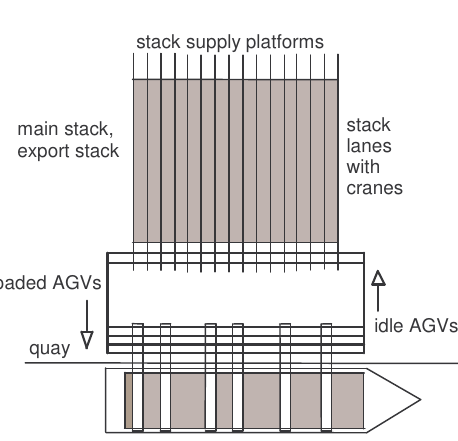
Figure 1. Circular shuttle between quay and stack